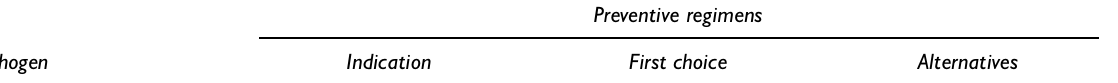
Table 12 Prophylaxis to prevent first episode of opportunistic disease in infants and children infected with human immunodeficiency